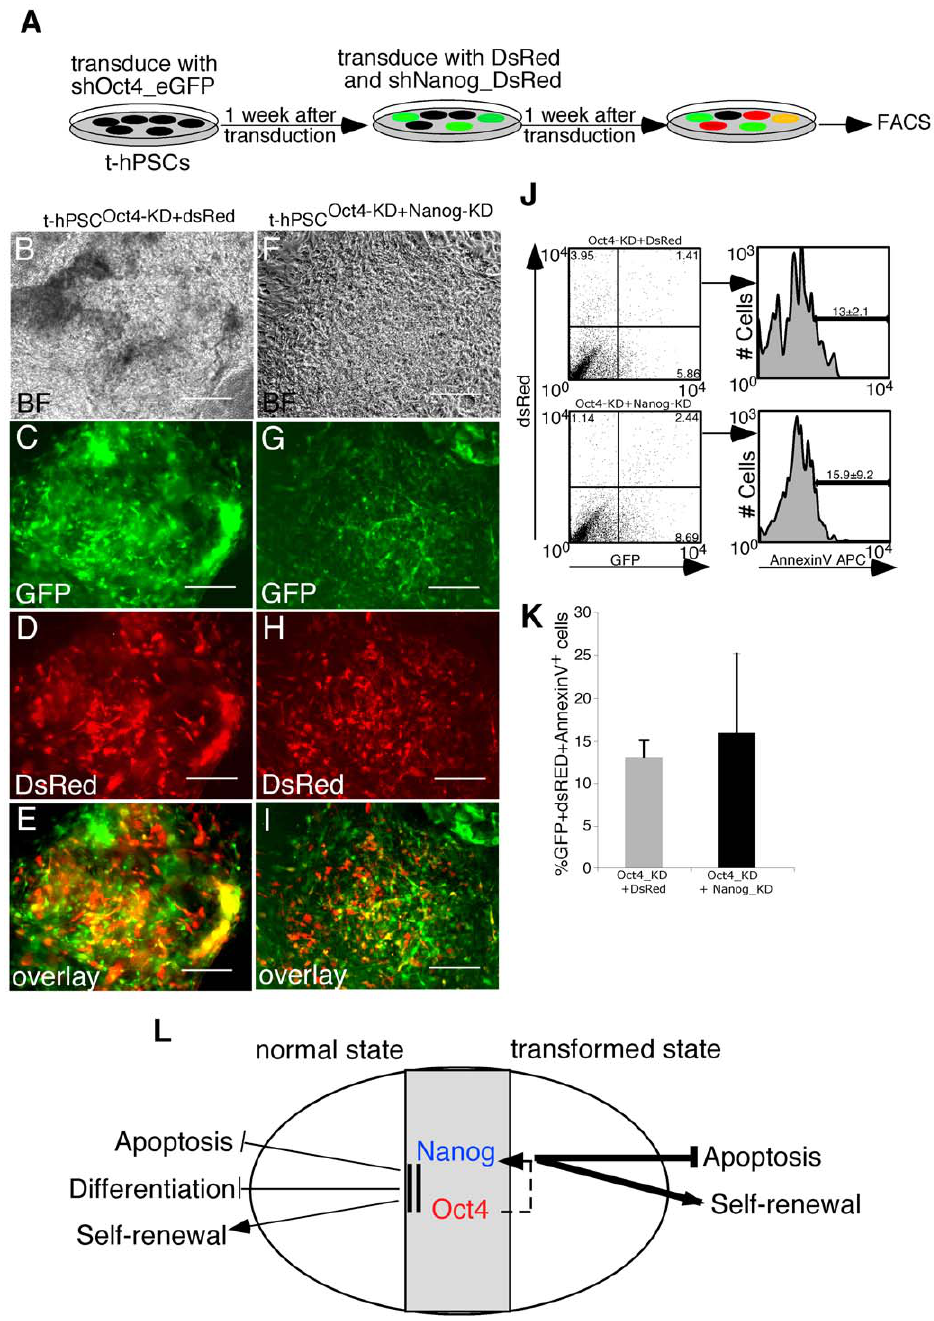
Figure 4. Survival of t-hPSCs after dual and sequential knockdown of Oct4 and Nanog. (A) Schematic showing the protocol for dual and sequential knockdown of Oct4 and Nanog in t-hPSCs. (B–I) Representative images of control (B–E) and dual Oct4 and Nanog knockdown (F–I) t-hPSCs 2 weeks after transduction with the shOct4_GFP vector followed by control DsRed and shNanog_DsRed vectors, respectively. Scale bar=100 m m, n=3. Images are representative of individual colonies seen throughout the entire culture. Note the significant overlay between Oct4 KD-dsRED (E) and Oct4 KD-Nanog KD (I) demonstrating that Oct4 and Nanog are downregulated in the same cells. (J) Representative FACS results showing the frequencies of Annexin V + cells within GFP + DsRed + fractions of control and dual Oct4 and Nanog knockdown t-hPSCs. n=3. (K) Frequency of Annexin V + cells within GFP + DsRed + fractions of control and dual Oct4 and Nanog knockdown t-hPSCs. (13 6 2.1% AnnexinV + cells in Oct4 KD/dsRED t-hPSC controls vs 15.9 6 9.2% Annexin V + cells in Oct4 KD/Nanog KD-dsRED t-hPSCs. Bar graphs represent mean values 6 SEM, n=3, p . 0.05. (L) While both Oct4 and Nanog are required to sustain the normal human stem cell pluripotent state, Oct4 is dispensable for transformed human stem cell self- renewal and survival. However, transformed human stem cells are completely dependent on Nanog for both self-renewal and survival revealing a fundamental paradigm shift in the role of core TFs following transformation. This heightened effect of Nanog on transformed cell survival is dependent on